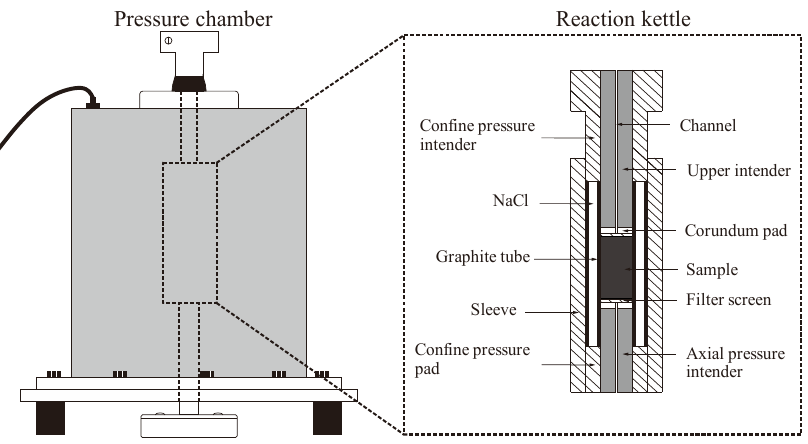
Figure 2. A schematic diagram of the deformation experimental system (modified from Liu et al.